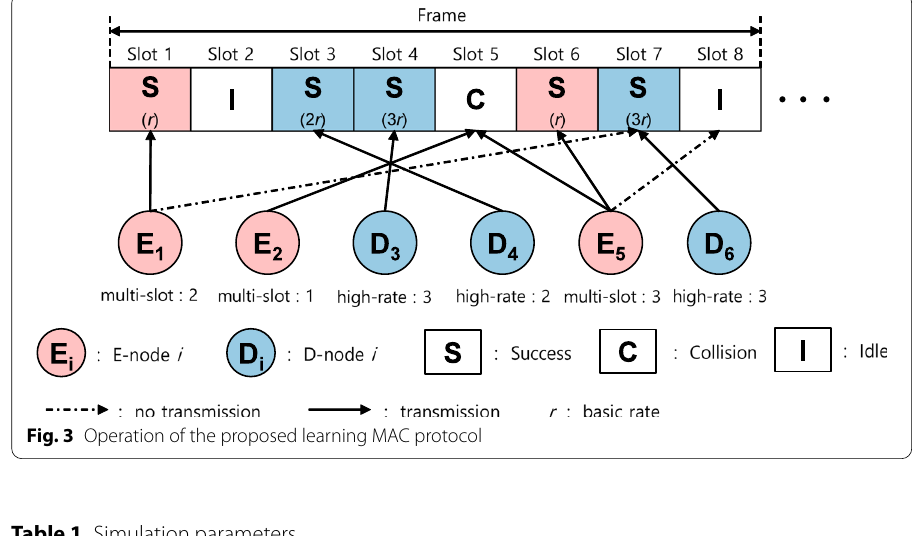
Fig. 3 Operation of the proposed learning MAC protocol